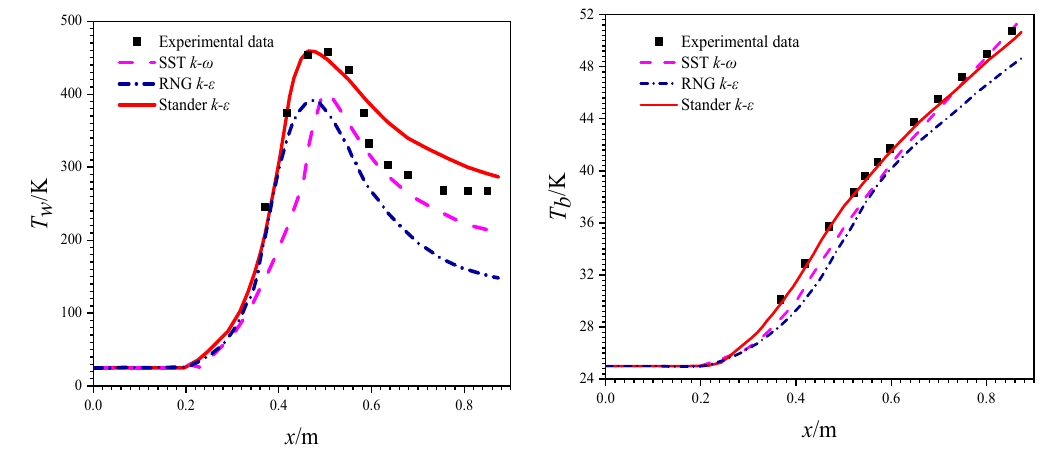
Figure 5. Sensitivity analysis of the turbulence model.